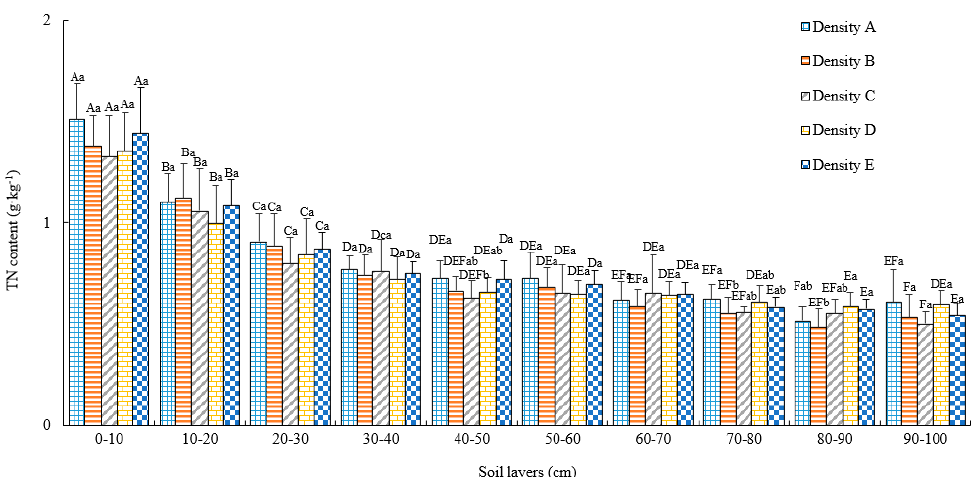
Figure 3. Soil total N in di ff erent layers under di ff erent stand densities (g · kg − 1 ). Note: di ff erent lowercase letters indicate significant di ff erences among di ff erent densities at the 0.05 level, and di ff erent capital letters for the same density indicate significant di ff erences among di ff erent soil layers at the 0.05